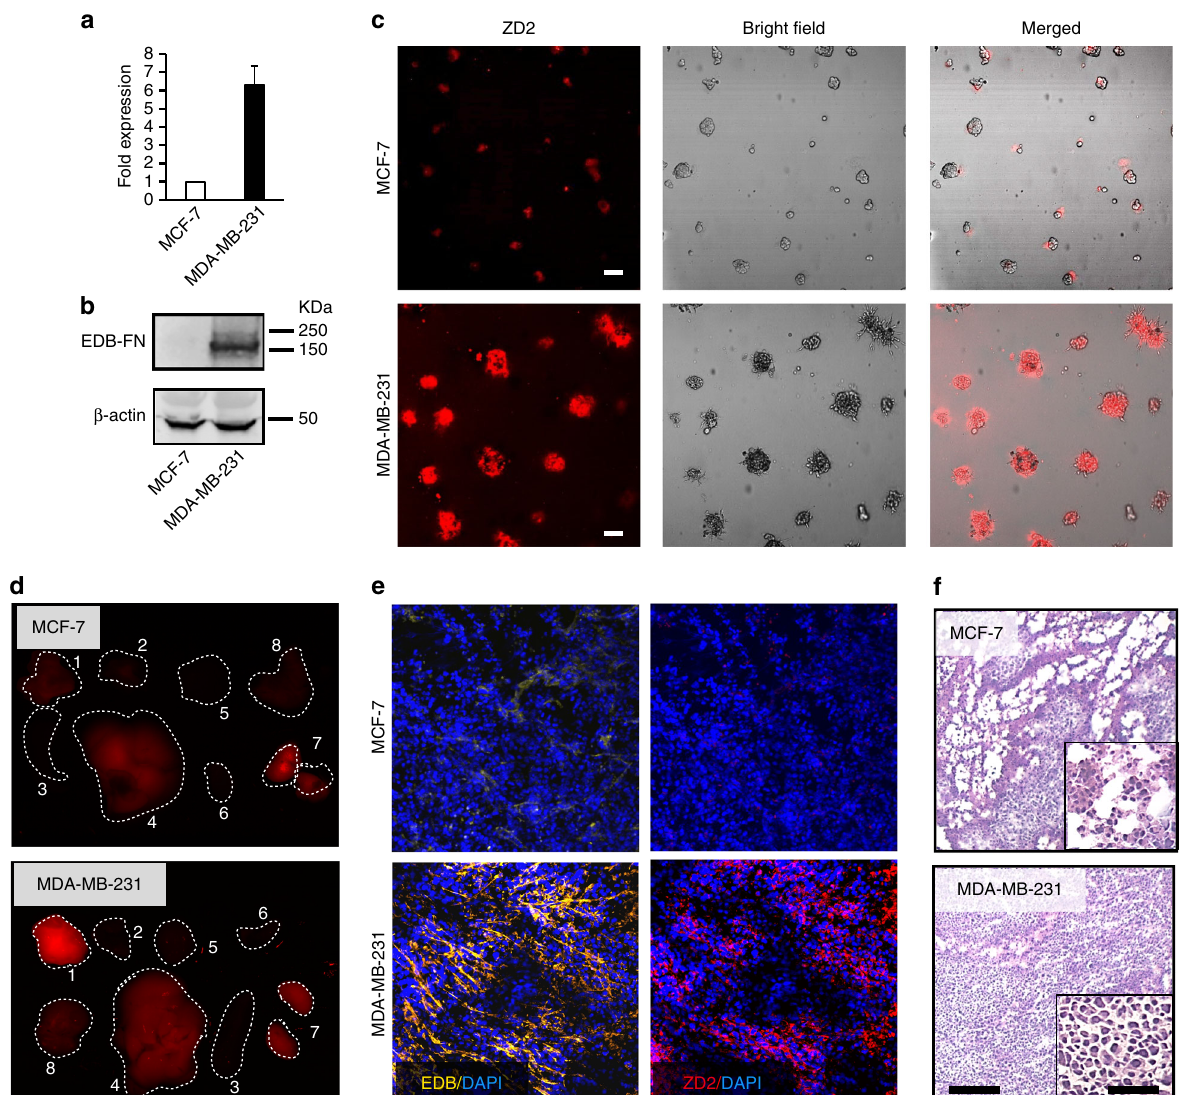
Fig. 3 EDB-FN overexpression is a signature of aggressive breast cancer. a RT-PCR analysis of EDB-FN mRNA levels in MCF-7 and MDA-MB-231 cells, showing increased EDB-FN expression in MDA-MB-231 cells (data are presented as mean ± s.e.m. n = 3; two-tailed t -test: P < 0.05). The data are presented as ratios to the mRNA level of MCF-7. The mRNA level of β -actin was used for normalisation. b Western blot analysis of EDB-FN expression in MCF-7 and MDA-MB-231 tumours. β -actin was used as a loading control. c Representative fl uorescence images of ZD2-Cy5.5 ( red ) binding, bright fi eld images of 3D culture of MCF-7 and MDA-MB-231 cells, and the overlay of fl uorescence images with bright fi eld images. Scale bar 50 µ m. d Ex vivo fl uorescence images of tumour and organs collected from mice bearing MCF-7 and MDA-MB-231 tumours at 3 h after injection of 10 nmol ZD2-Cy5.5. Numbers in the images indicate the following tissues: 1 tumour; 2 muscle; 3 spleen; 4 liver; 5 brain; 6 heart; 7 kidney; 8 lung. e Analysis of EDB-FN expression and ZD2-Cy5.5 binding in MCF-7 and MDA-MB-231 tumour sections. DAPI was used for staining nuclei. Pseudo-colours in the confocal images are assigned as follows: red , ZD2 peptide; green , BC-1; and blue , nucleus. Scale bar 25 µ m. f H&E staining showing the morphology of MCF-7 and MDA-MB-231 tumour sections. Scale bar 50 µ m. Inset : enlarged images of the tumour sections ( scale bar 10 µ